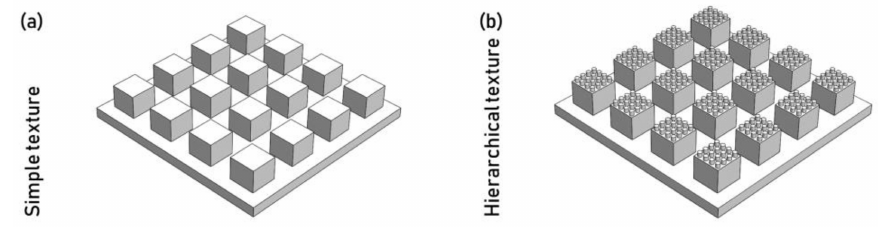
Figure 15. Schematic of ( a ) a texture with structures of the same order of magnitude and ( b ) of a hierarchical